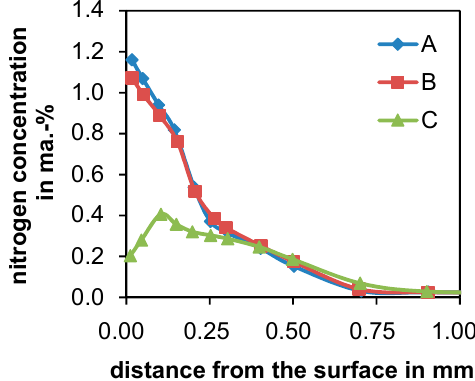
Figure 2. Nitrogen profiles after carbonitriding of the material X38CrMoV5-3 with different process management (for heat treatment parameters of A, B and C see Table 2).